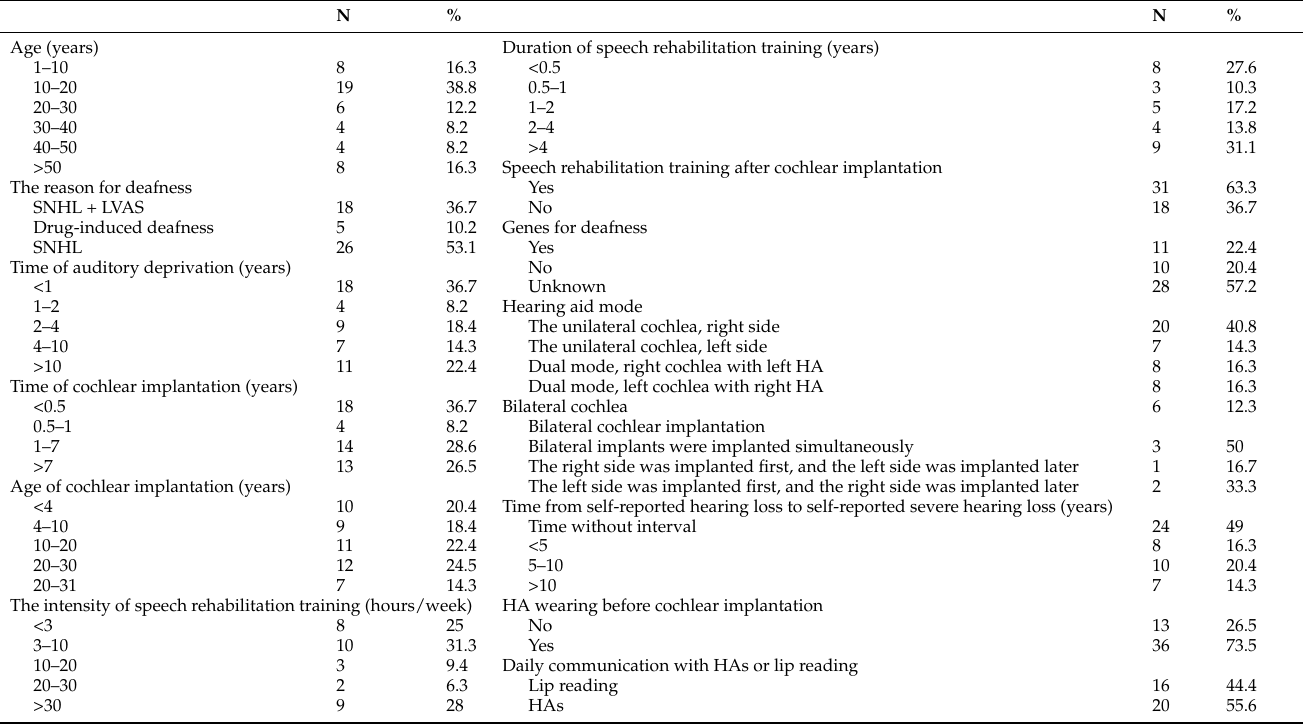
Table 1. The clinical characteristics of 49 CI subjects.